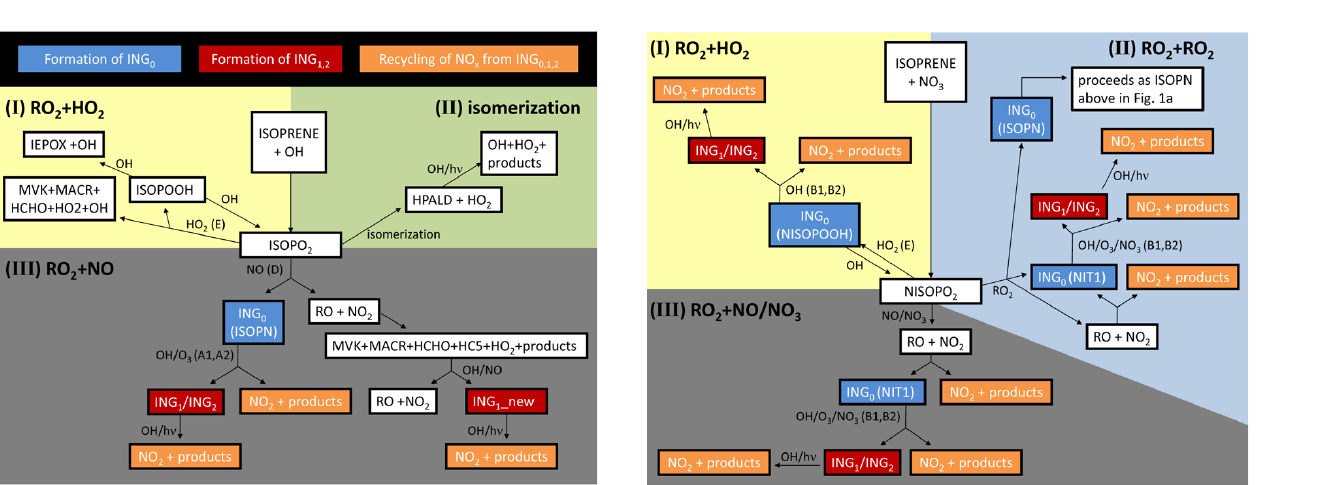
Fig. 1b. Updated oxidation scheme for isoprene + NO 3 . The colors retain the same meaning as in Fig.